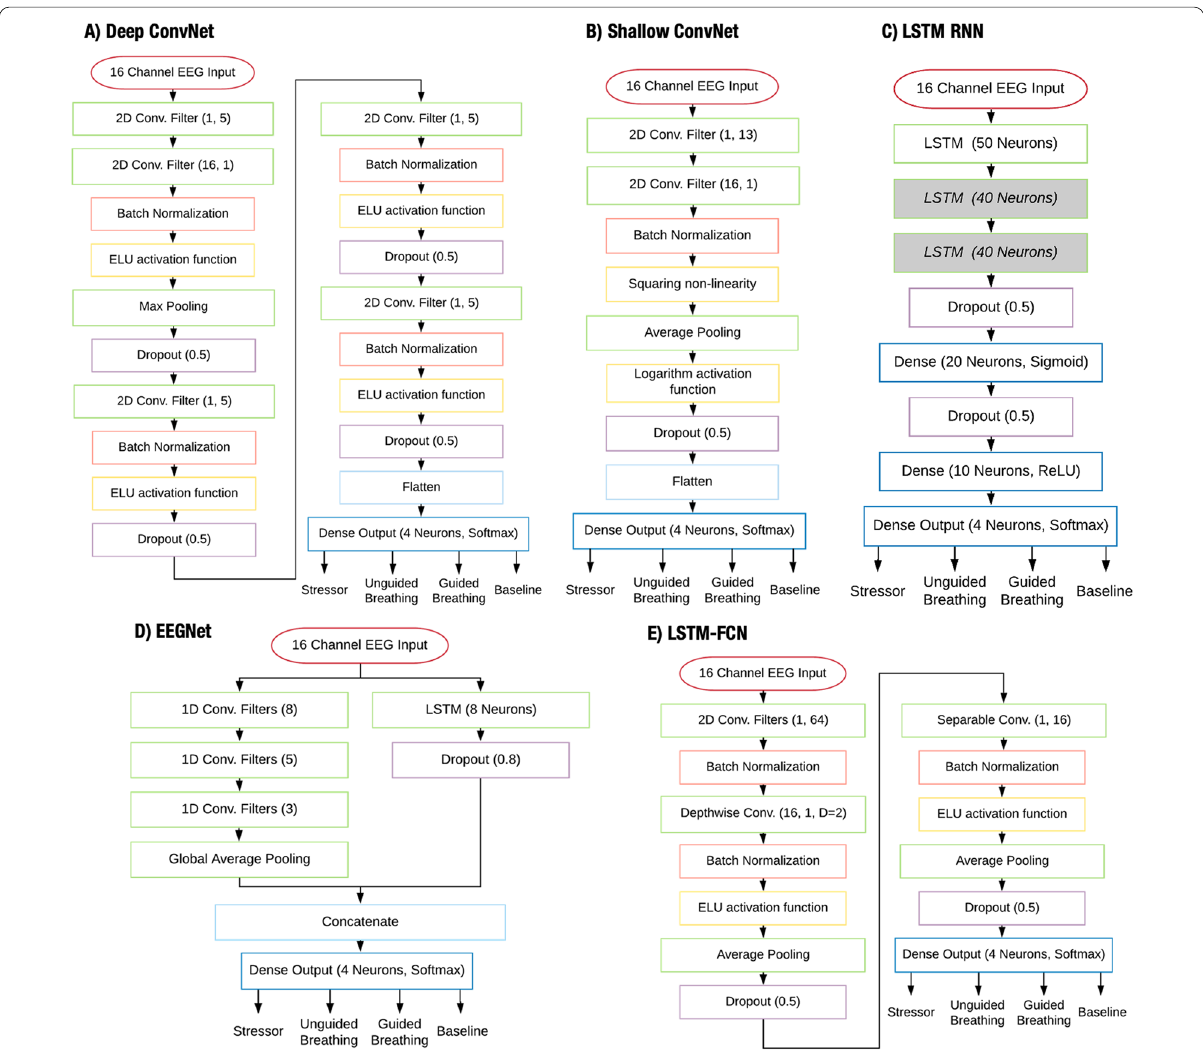
Fig. 2 Diagram of the model architectures for the A Deep ConvNet, B Shallow ConvNet, C LSTM RNN, D EEGNet and E LSTM‑FCN. Note: the first grayed layer of the LSTM RNN was only implemented for the two‑ and three‑layer LSTM while the second grayed layer is only applicable to the three‑layer